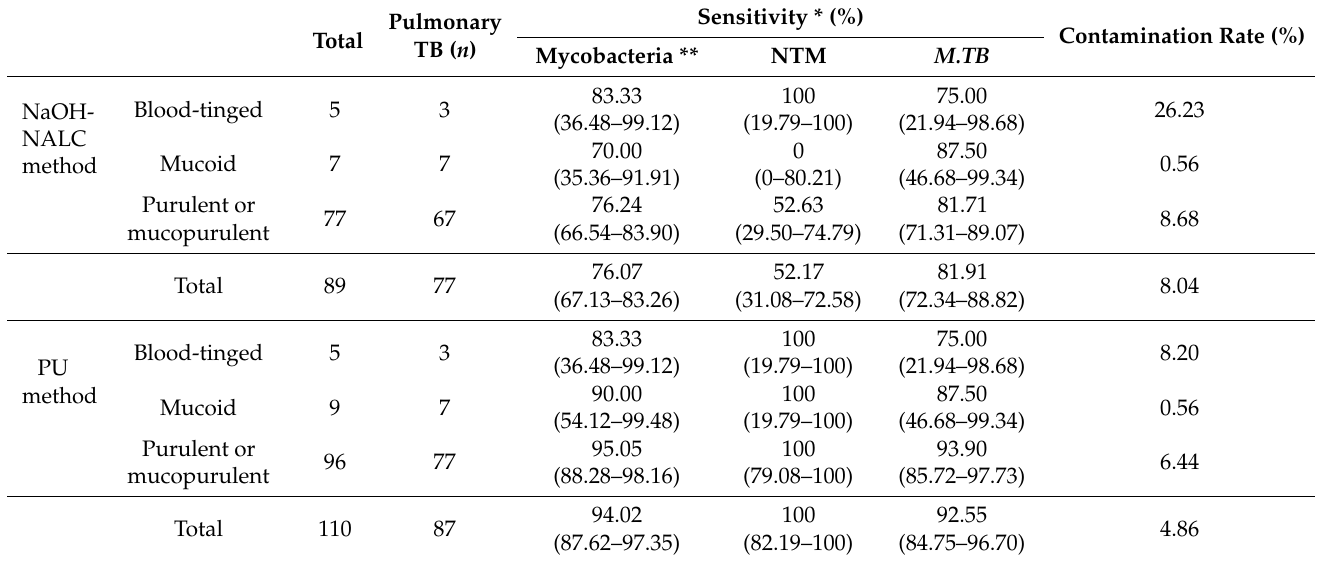
Table 3. Comparison of culture results for NaOH-NALC and PU methods based on sputum appearance. Pulmonary Total TB ( n